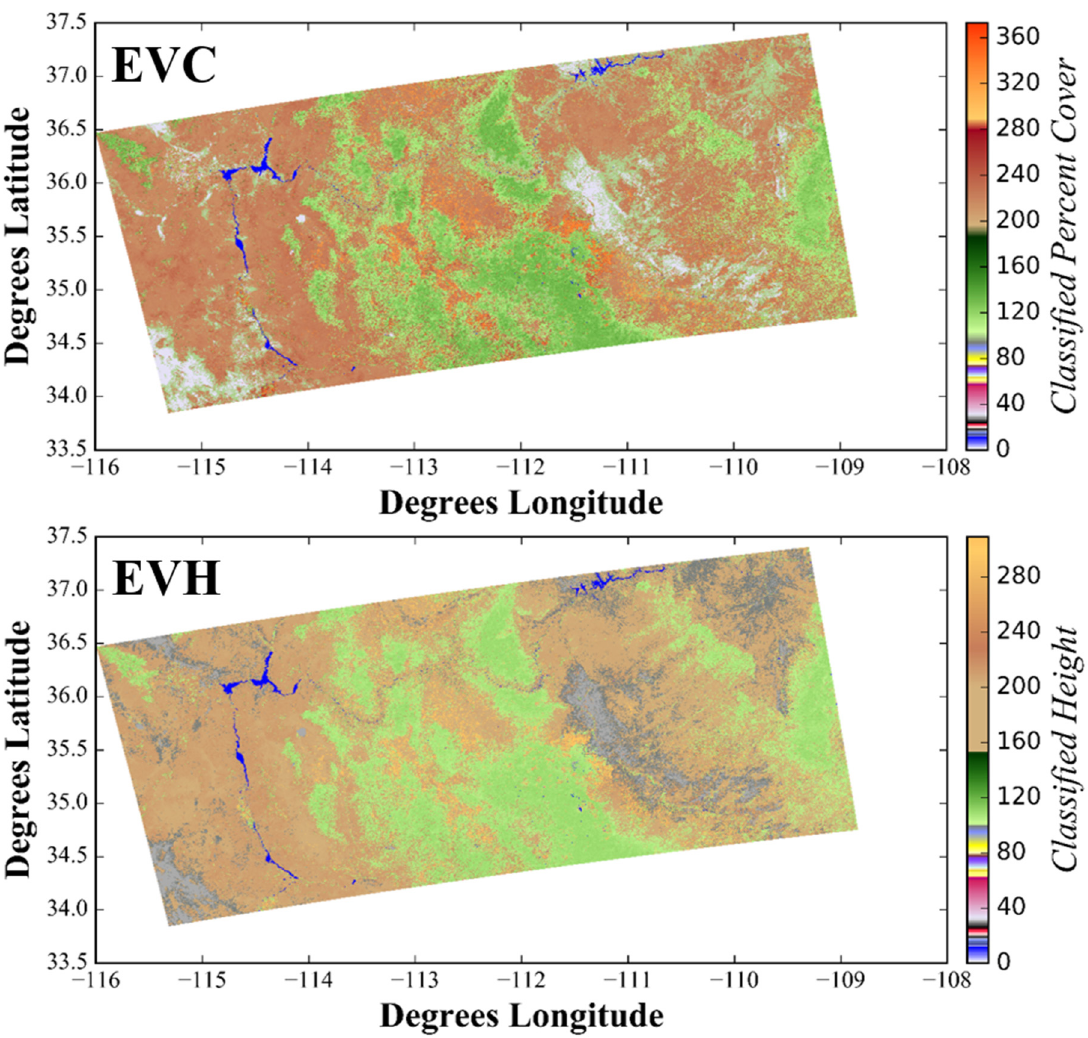
Figure 9. Existing Vegetation Cover (EVC) classified percent cover and Existing Vegetation Height (EVH) products within the Grand Canyon prototype area. Both EVC and EVH are classified by lifeform values with values of 100s, 200s, and 300s representing tree, herb, and shrub classes, respectively. EVC values in percent cover can be calculated by subtracting 100, 200, or 300 from the value. EVH can be calculated the same way as EVC, although values are in meters (tree), centimeters (shrub), and decimeters (herb). All values below 100 are specific thematic classes (e.g., water, value = 11). A segmented EVT map (Figure 12A.) was produced in addition to the original EVT map (Figure 10, left) for the NW. Di ff erences in pixilation are evident when the EVT (Figure 12B.) map is compared to the segmented EVT map (Figure 12C.) for a portion of the NW, with the segmented map exhibiting reduced pixilation. Segmented EVT maps required an order of magnitude more processing time for